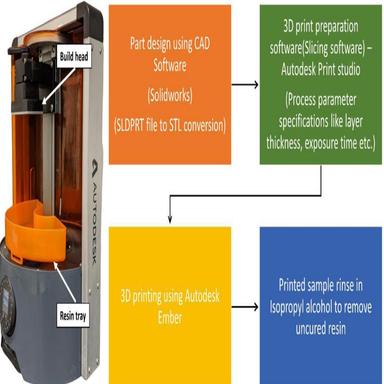
Autodesk Ember 3D printer and basic steps in the 3D printing process.